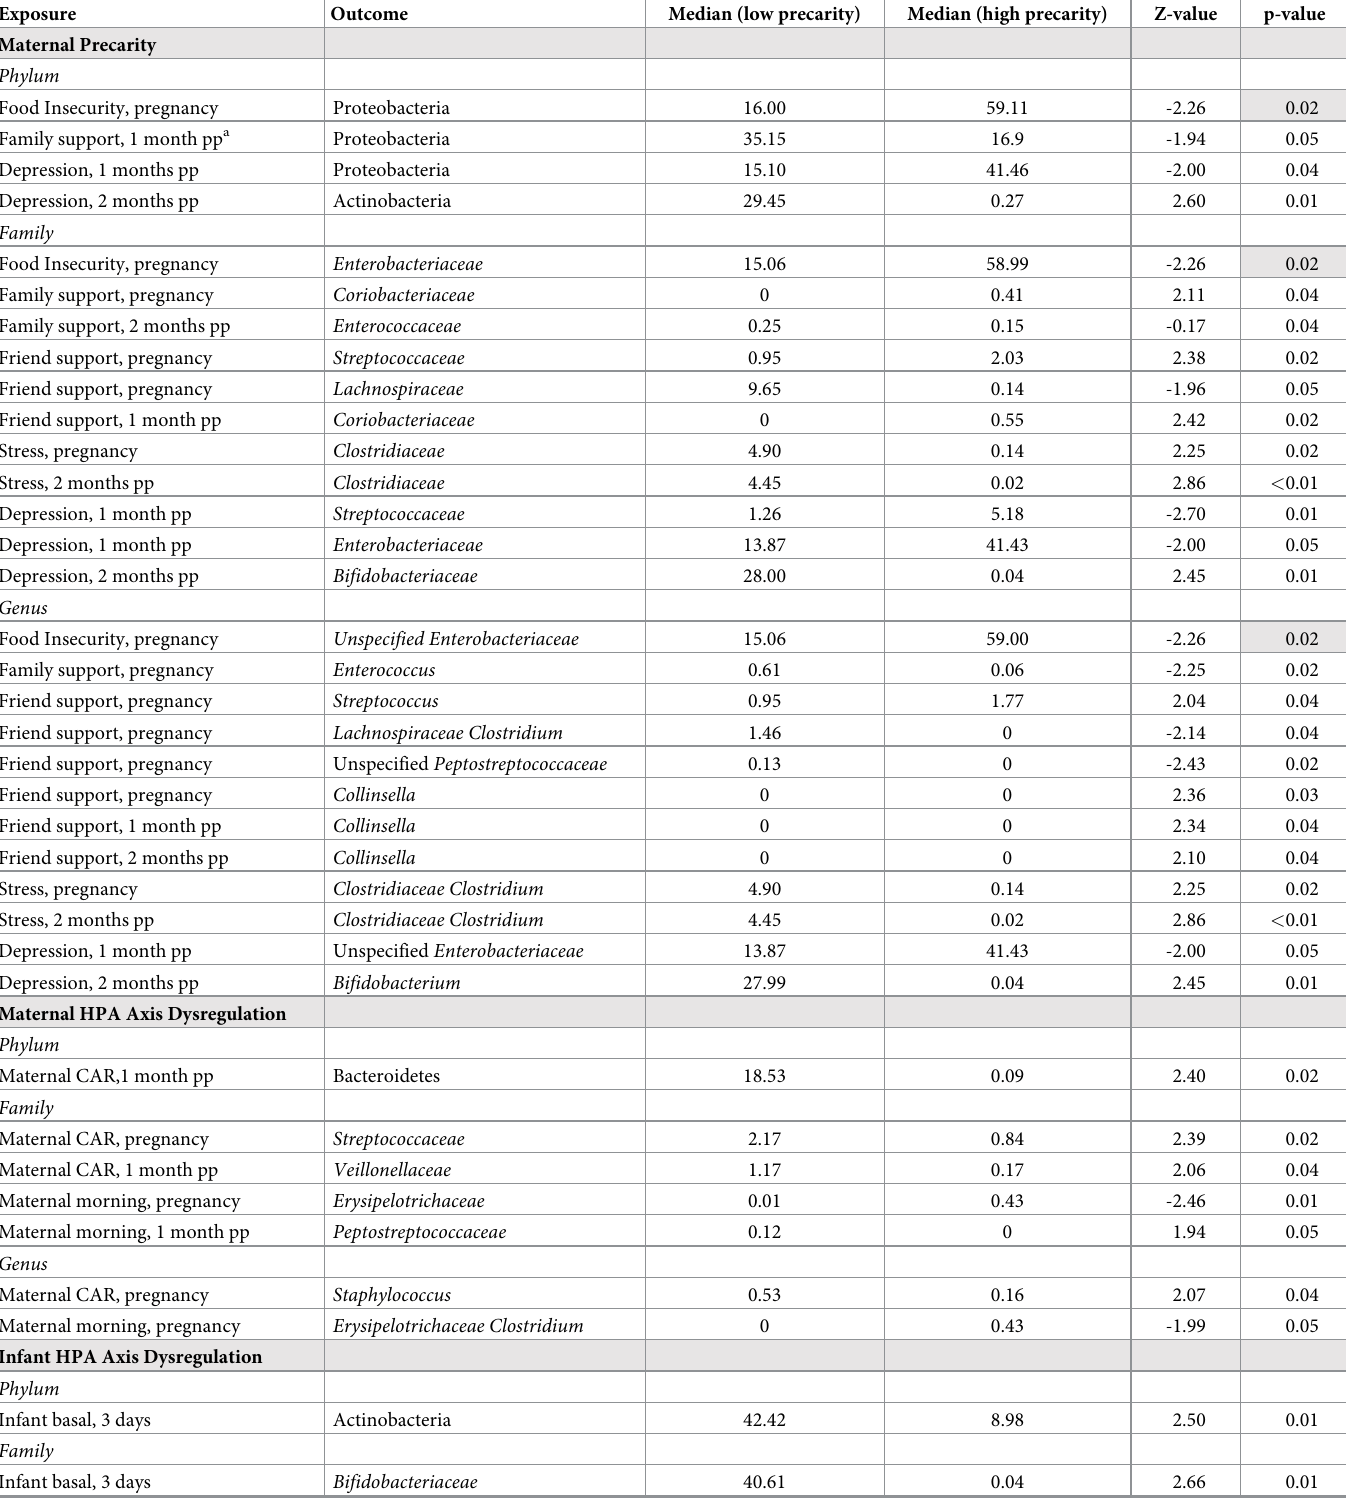
Table 3. Maternal precarity and maternal and infant HPA axis dysregulation are associated with differences in taxa abundance in bivariate